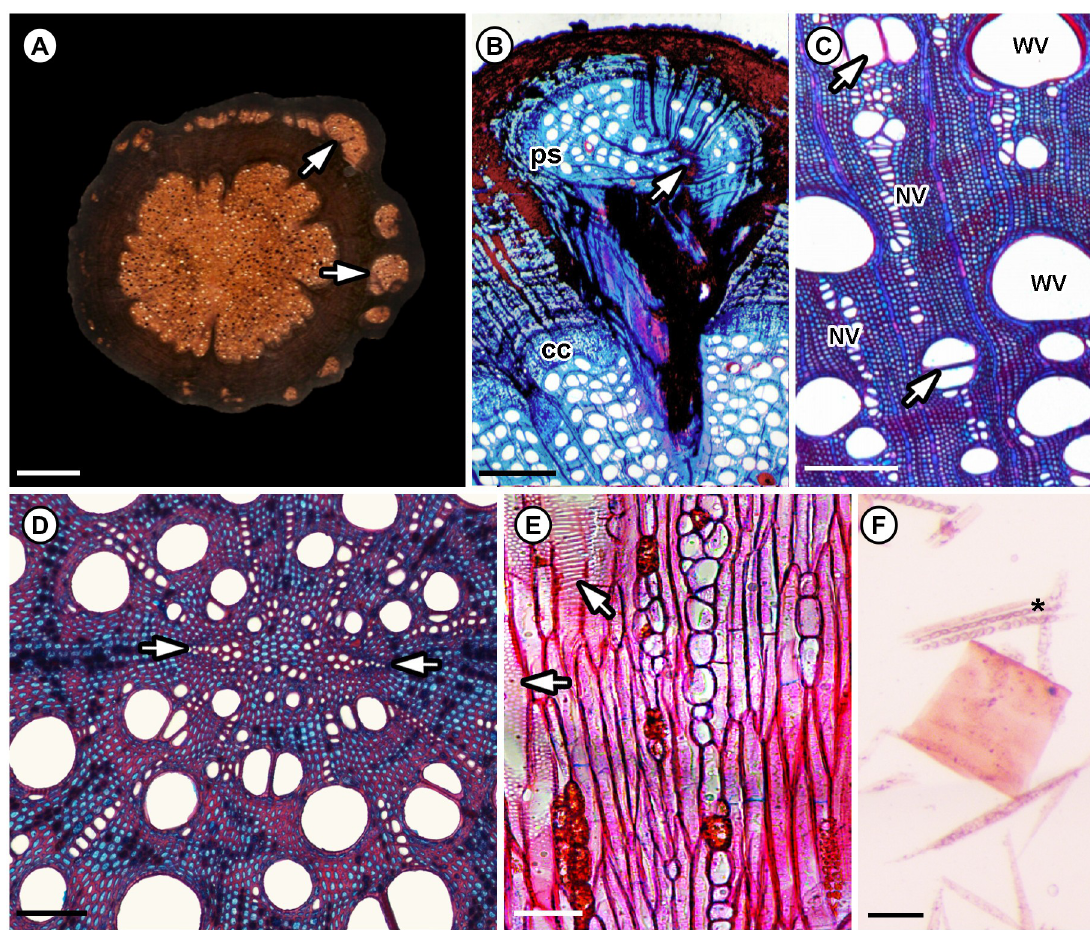
Fig 4. Wood anatomy of the roots of extant Paullinieae species. A–B: Neoformations forming peripheral vascular strands in Serjania caracasana (Jacq.) Willd. in transverse section. (A) Root macromorphology presenting a cambial variant. Arrows point to individual peripheral vascular strands. (B) Close up of the juncture of the central cylinder (cc) and a peripheral vascular strand (ps) with a c-shaped “pith” (i.e., primary vascular parenchyma of the root). (C) Secondary xylem of Thinouia scandens Triana & Planch. with vessel dimorphism in transverse section. Note the wide vessels (WV) are solitary or in tangential (upper arrow) or radial multiples (lower arrow), while the narrow vessels (NV) are in longer radial chains. (D) Primary vascular parenchyma in the center of the the diarch roots (arrows towards protoxylem poles) of S. caracasana in transverse section. (E) Alternate intervessel pits (lower arrow) and those with coalescent apertures (upper arrow) in S. caracasana in tangential longitudinal section. (F) Prismatic crystals in the axial parenchyma ( � ) of S. caracasana in macerated material. Scale bars: A = 0.5 cm, B = 1 mm, C = 250 μ m, D = 100 μ m, E = 70 μ m, F = 50 μ m. � prismatic crystals in axial parenchyma. based on leaves from the Eocene Aycross Formation in northwestern Wyoming. The same species also occurs in the Eocene Bridger Formation in southwestern Wyoming [75]. “Cardios- permum” terminale (Lesquereux) MacGinitie was first described from the Eocene Florissant Formation in central Colorado by Lesquereux [76] as Lomatia . MacGinitie [77] transferred these specimens and others to Cardiospermum based on the twice-ternate leaf organization and architecture of lobes, teeth, and major vein framework of the leaflets. This species was later reported from the late Eocene to early Oligocene Climbing Arrow Member of the Renova Formation in southwestern Montana [78, 79] as well. Finally, “Cardiospermum” coloradensis (Knowlton) MacGinitie was first described from the Eocene Green River Formation as Phyl- lites by Knowlton [80]; and later transferred to Cardiospermum by MacGinitie [81]. This